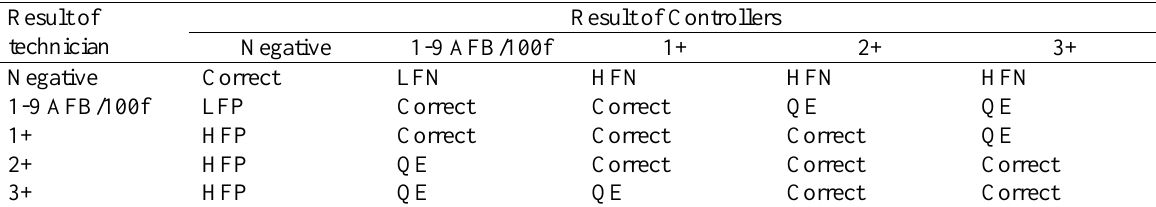
Result of Controllers